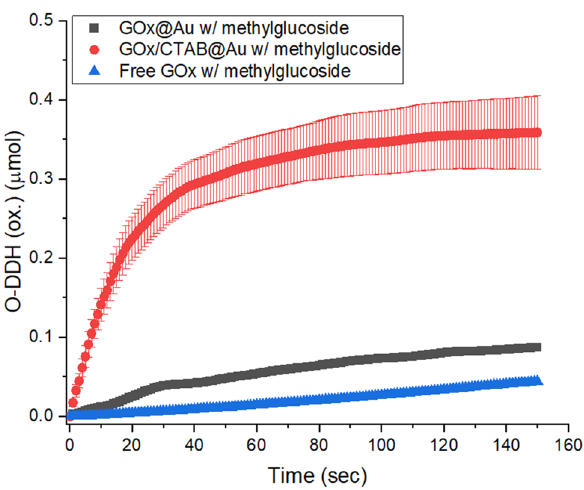
Figure 7. Activity of free GOx on methylglucoside: GOx@Au (red), GOx/CTAB@Au (black) and free GOx (blue) on methylglucoside